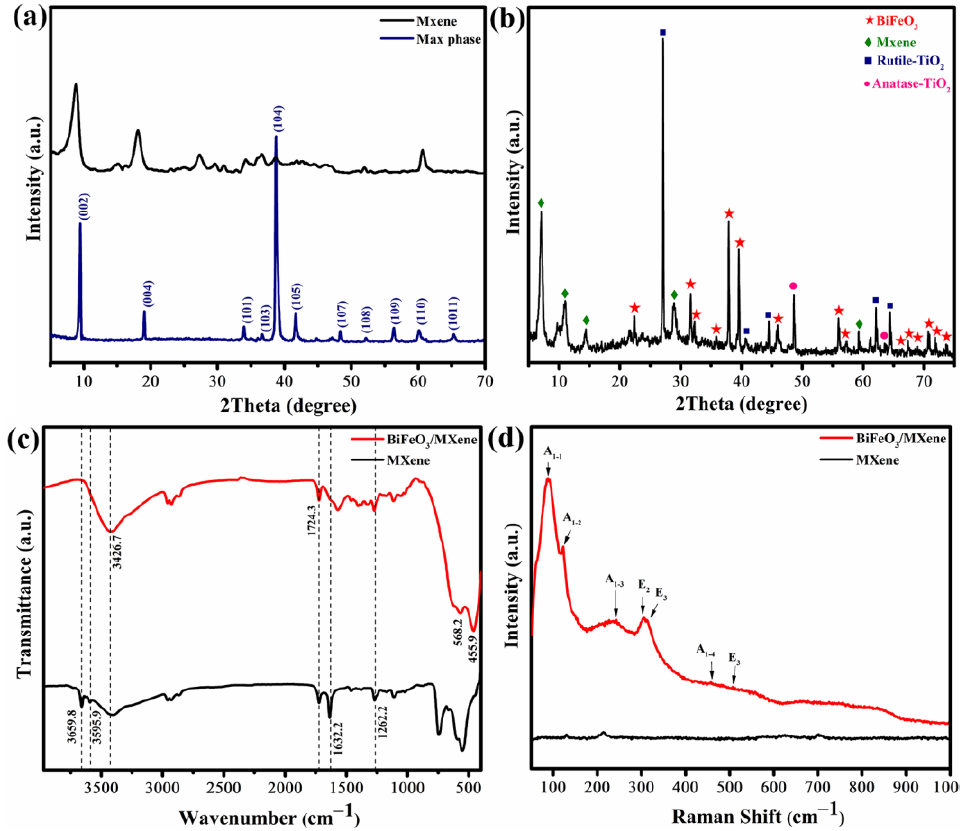
Figure 1. XRD of ( a ) MAX phase and Mxene and ( b ) BiFeO 3 /Mxene, ( c ) FTIR, and ( d ) Raman spectra of Mxene and BiFeO 3 /Mxene.